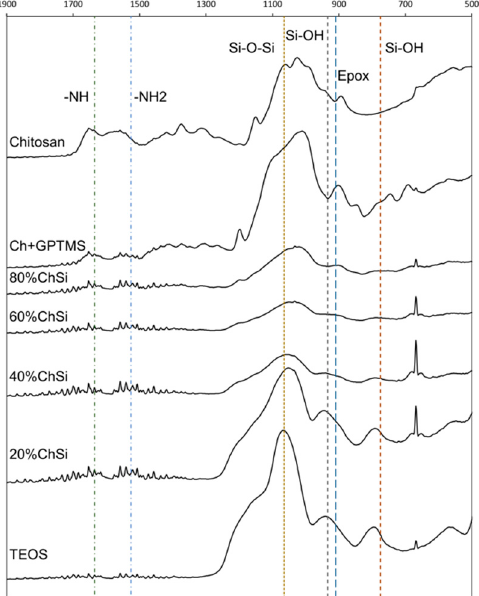
Figure7. Infraredanalysesofchemicalstructuresinhybridmaterials. TotalreflectanceFouriertransform Figure 7. Infrared analyses of chemical structures in hybrid materials. Total reflectance Fourier infrared (ATR-FTIR) spectra of chitosan, chitosan coupled with 3-glycidyloxypropyltrimethoxysilane transform infrared (ATR-FTIR) spectra of chitosan, chitosan coupled with 3- (Ch + GPTMS), hybrid materials (80–20% ChSi) and pure inorganic siloxane (condensed TEOS). glycidyloxypropyltrimethoxysilane (Ch+GPTMS), hybrid materials (80%–20% ChSi) and pure There were more peaks attributed to chitosan and GPTMS (-NH, -NH 2 , Epox) for hybrid materials with inorganic siloxane (condensed TEOS). There were more peaks attributed to chitosan and GPTMS higher organic content. Their chemical characteristics were more similar to a purely inorganic siloxane (-NH, -NH 2 , Epox) for hybrid materials with higher organic content. Their chemical characteristics network (Si–O–Si, Si–OH), as the organic fraction were more similar to a purely inorganic siloxane network (Si–O–Si, Si–OH), as the organic fraction decreased.